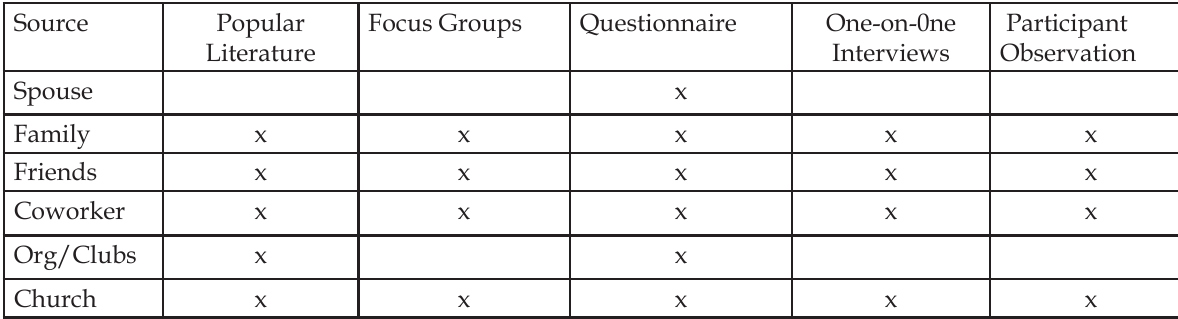
Table I. Sources of emotional support